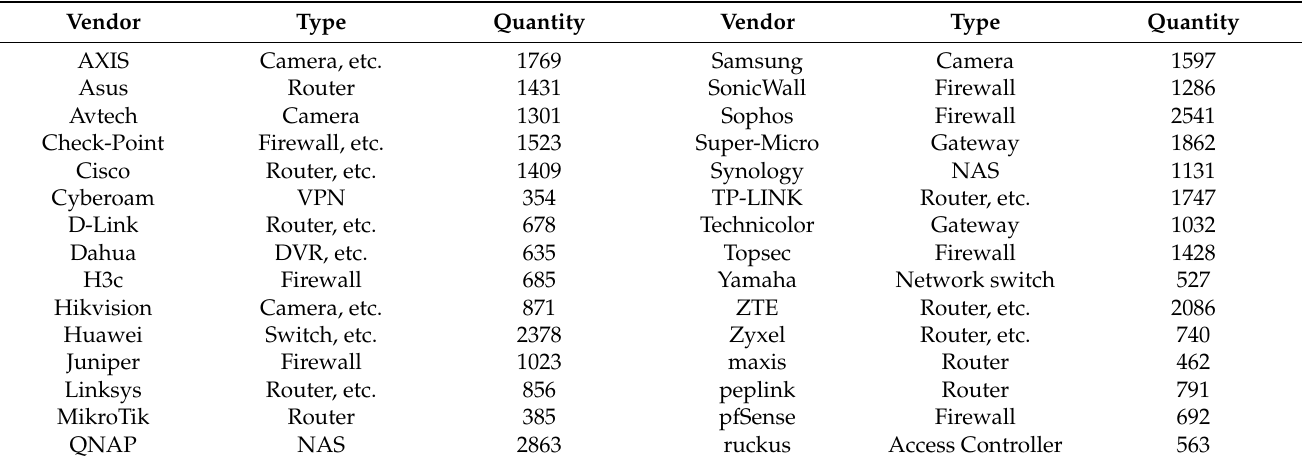
Table 1. 30 IoT vendor